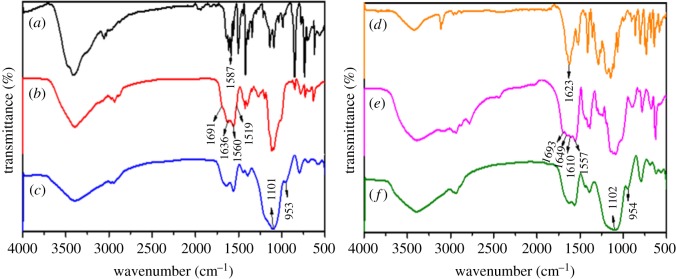
FT-IR spectra of phen (a), SiO2@ANA-Si-Tb-phen (b), SiO2@ANA-Si-Tb-phen@SiO2 (c), TTA (d), SiO2@ANA-Si-Tb-TTA (e) and SiO2@ANA-Si-Tb-TTA@SiO2 (f).